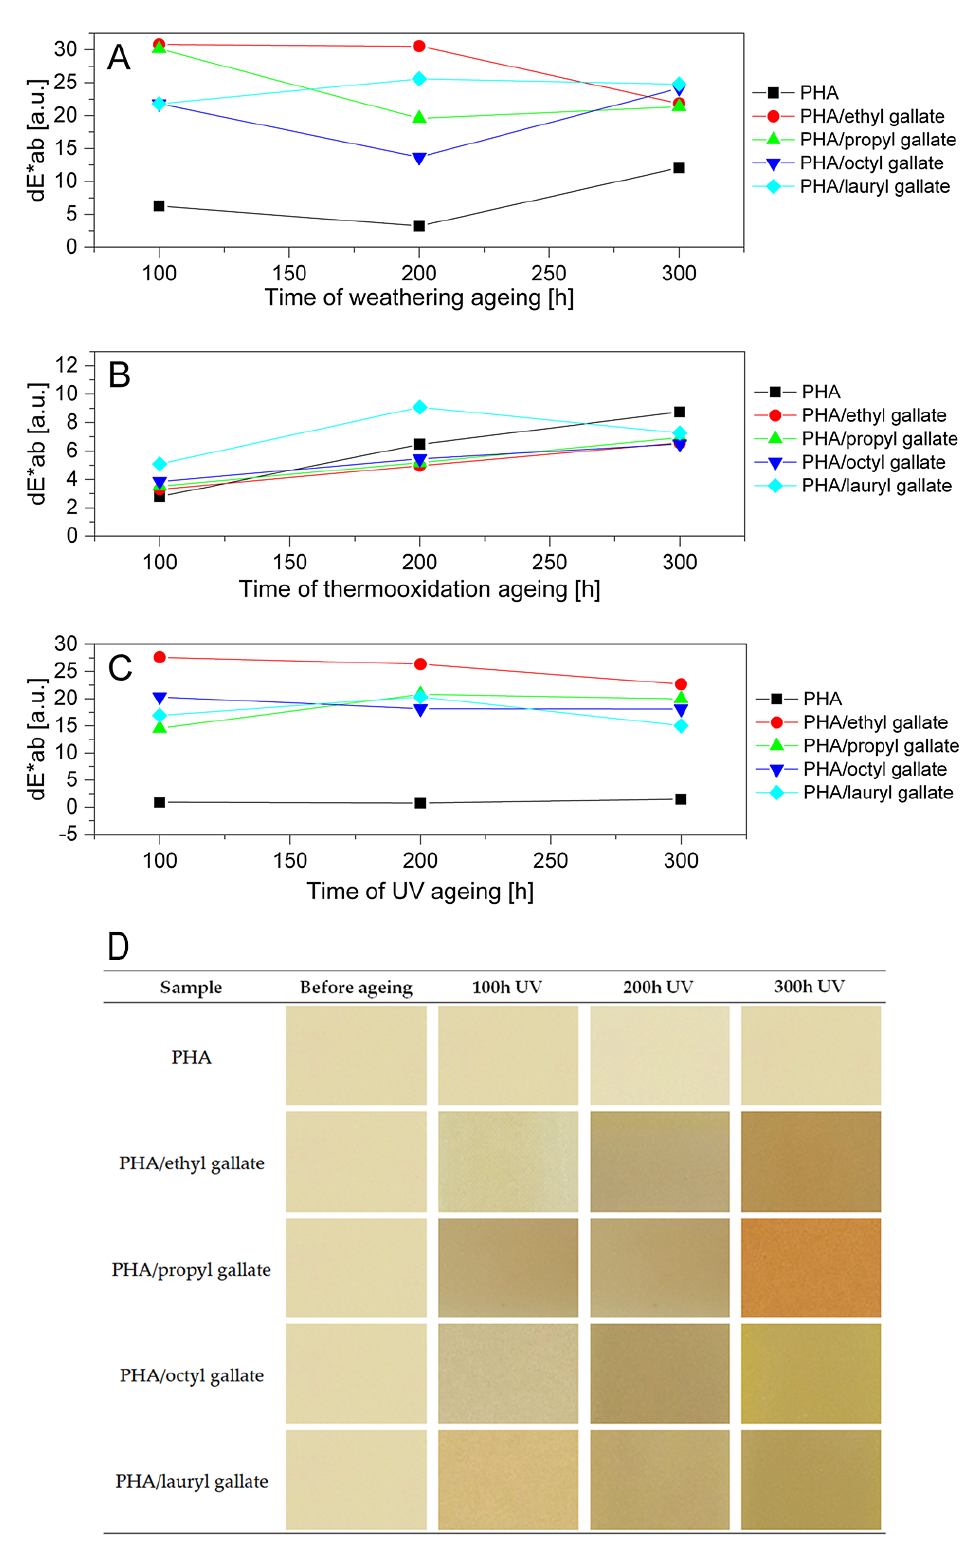
Figure 11. Changes in color of PHA after weathering ( A ), thermooxidation ( B ), and UV ( C ) aging. Visual change of color of PHA containing gallates before and after UV ageing ( D ).